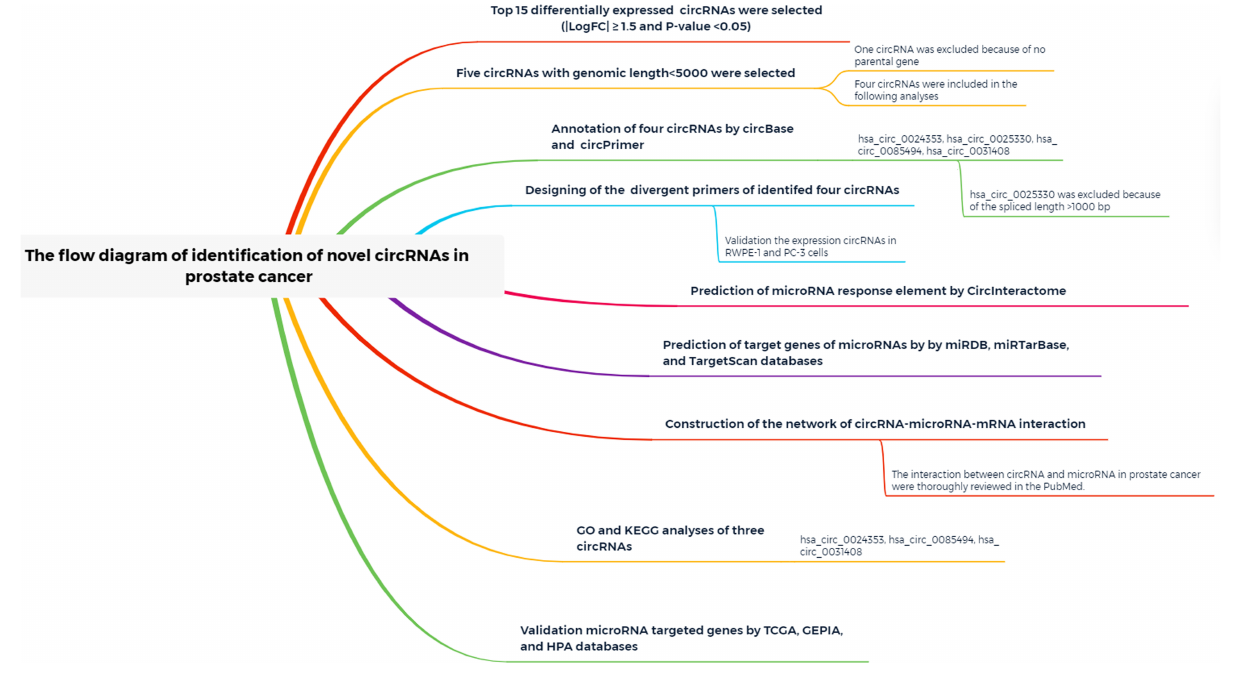
FIGURE 1 | Study flow diagram.